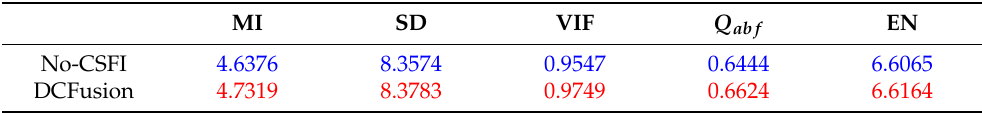
Table 7. The results of ablation study for the CSFI on the 361 MSRS dataset. The red value indicates the best result and the blue value indicates the second-best result.